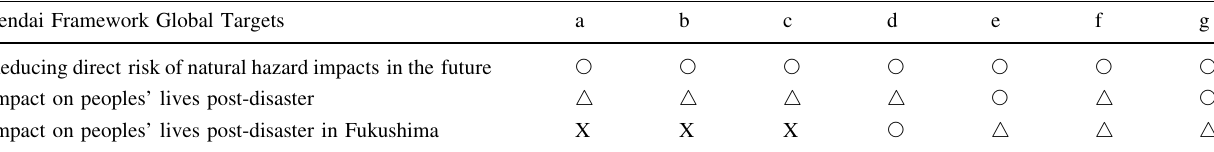
Table 4 Great East Japan Earthquake recovery contribution to the Sendai Framework global targets Sendai Framework Global